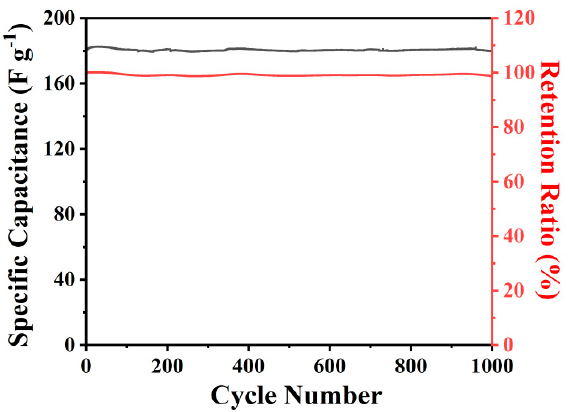
Figure 6. Cyclic performance of MPCNF − 750. Table 2. Comparation of the electrochemical performance of MPCNF-750 with other reported works.